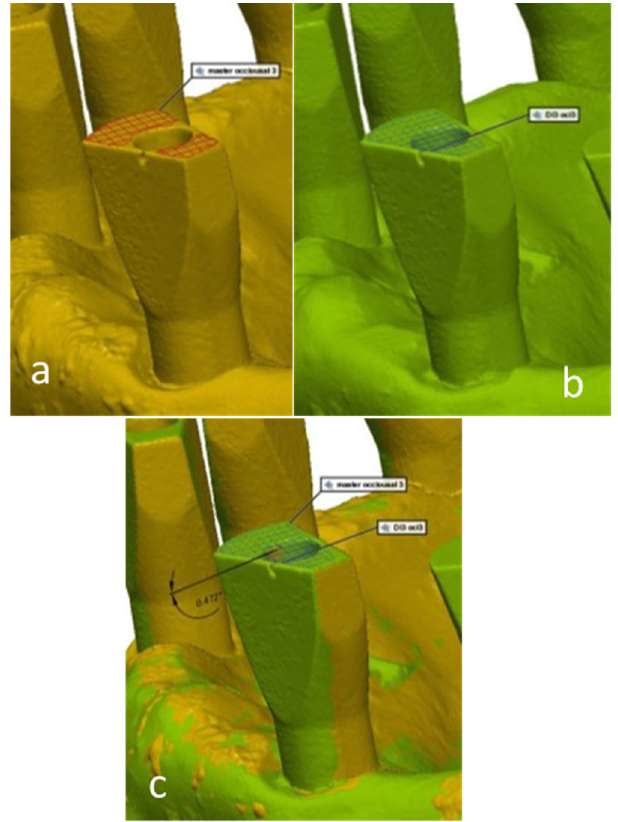
Figure 4. A digital 3D measurement of the angle between each matching scan abutment occlusal surface in the study model compared to the master model. ( a )—master model scan; ( b )—study group scan; ( c )—master model scan digitally overlapped with study group scan.